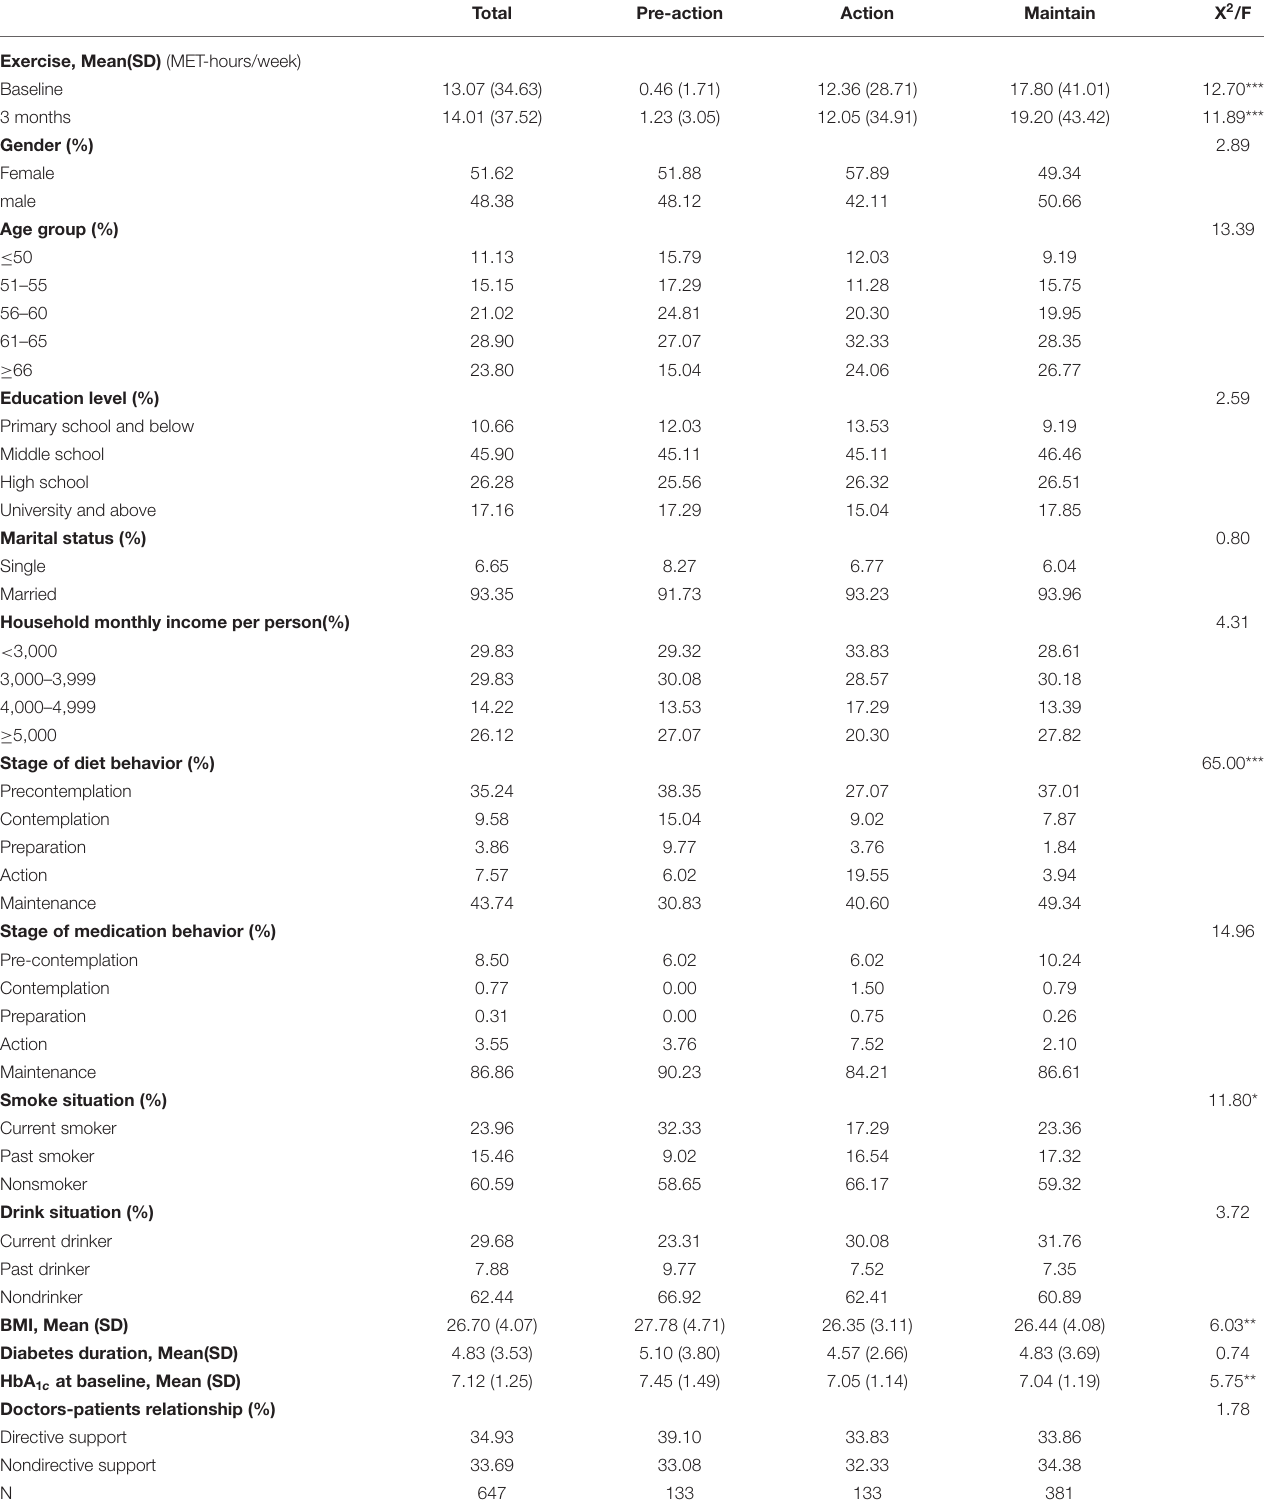
TABLE 1 | Change of exercise amount and baseline demographic characteristics across the stages of change. Total Pre-action Action Maintain X 2